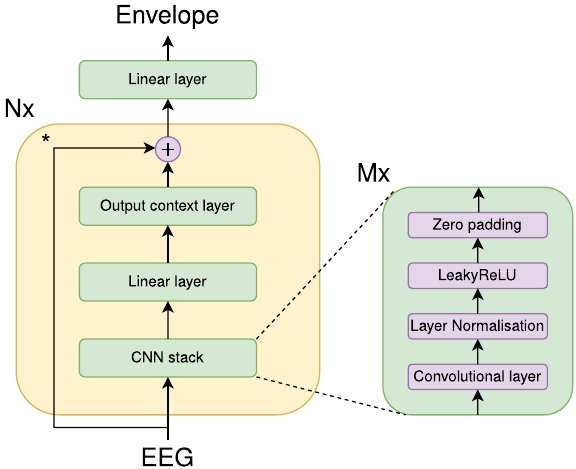
Figure 1. Structure of the proposed VLAAI network. The asterisk next to the skip connection indicates that it is not present in the last repetition of that